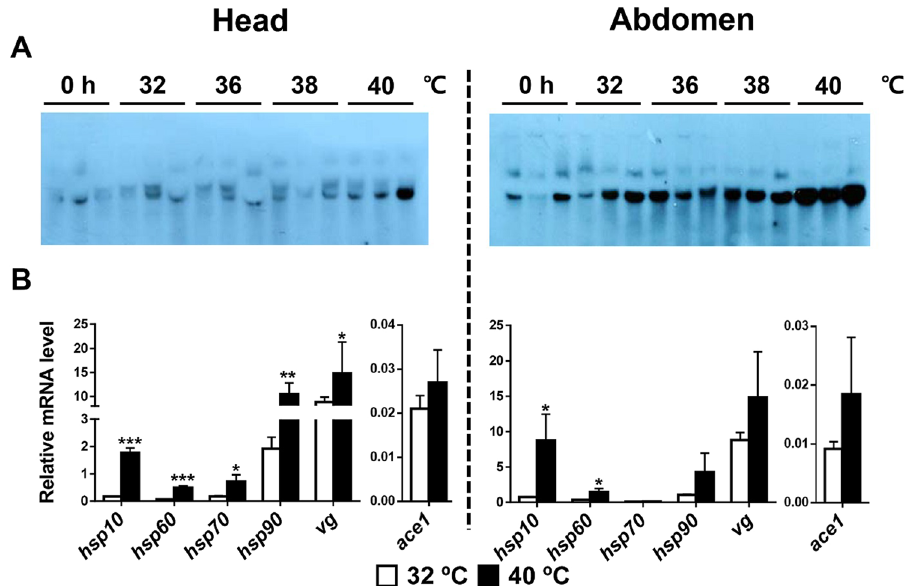
Figure 3. AmAChE1 expression profile and qPCR results of stress marker genes in in the head ( A ) and abdomen ( B ) of honey bees with heat shock treatment. Nurse bees were incubated at 32, 36, 38 and 40 °C for 24 h. Samples incubated at 32, 36, 38 and 40 °C were used to show the AmAChE1 expression level following heat shock (3 replicates per temperature condition) by Western blotting and samples incubated at 32 and 40 °C (3 replicates per temperature condition) were used for qPCR. The data was analyzed by Multiple t-test, and significant differences were marked with * ( p < 0.05), ** ( p < 0.01) and *** ( p <